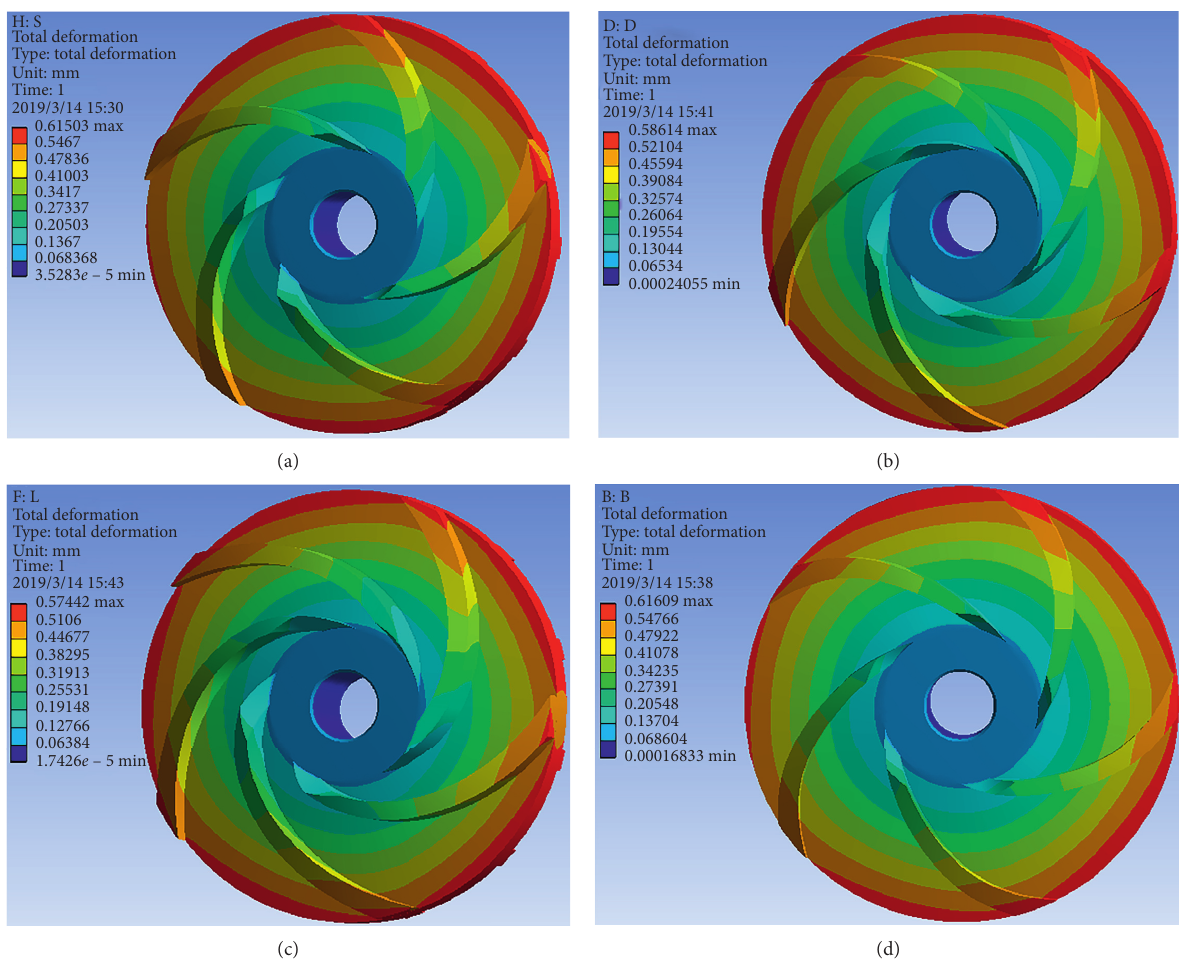
Figure 19: Total deformation of the impellers. (a) Single arc. (b) Double arc. (c) Logarithmic spiral. (d) B-spline curve.